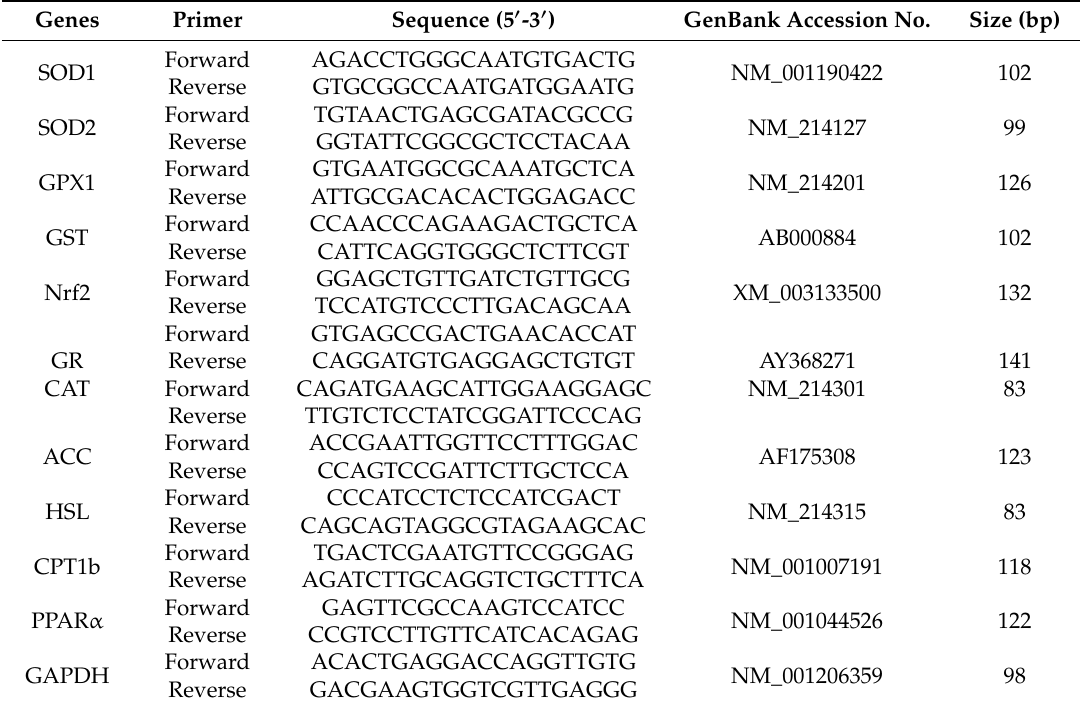
Table A2. Primer sequences used for real-time quantitative